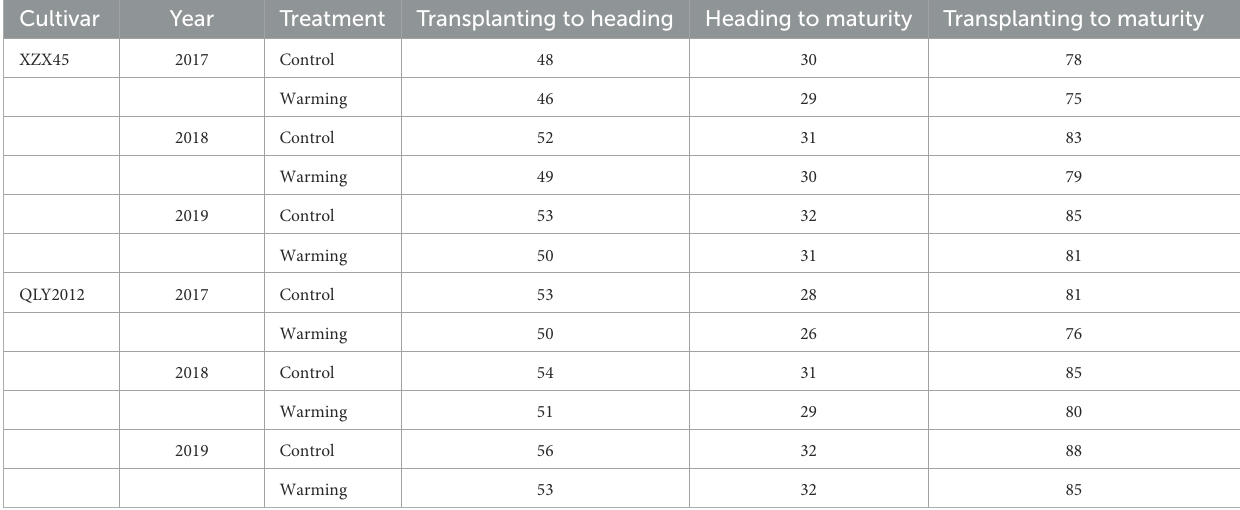
TABLE 2 Effect of warming on the growth duration (d) of early rice. Cultivar Treatment Transplanting to heading Heading to